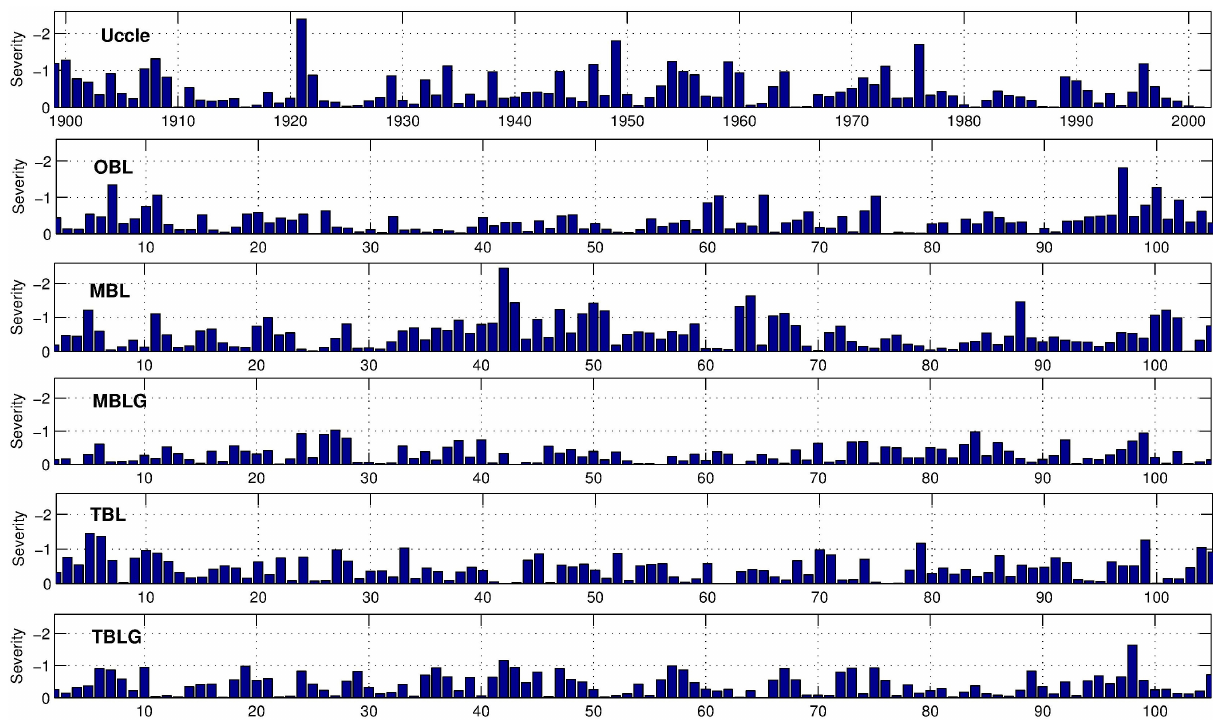
Fig. 3. Annual dryness of observed and modelled data represented by YAEDI 365 .